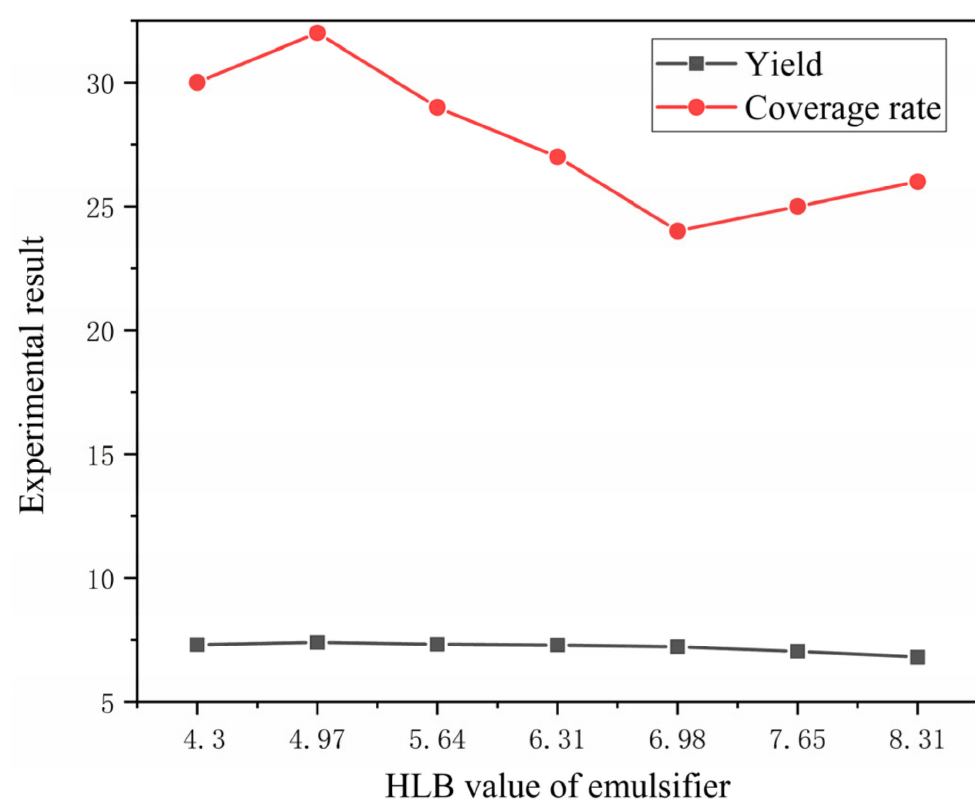
Figure 3. Relationship between HLB value and microcapsule yield and coverage